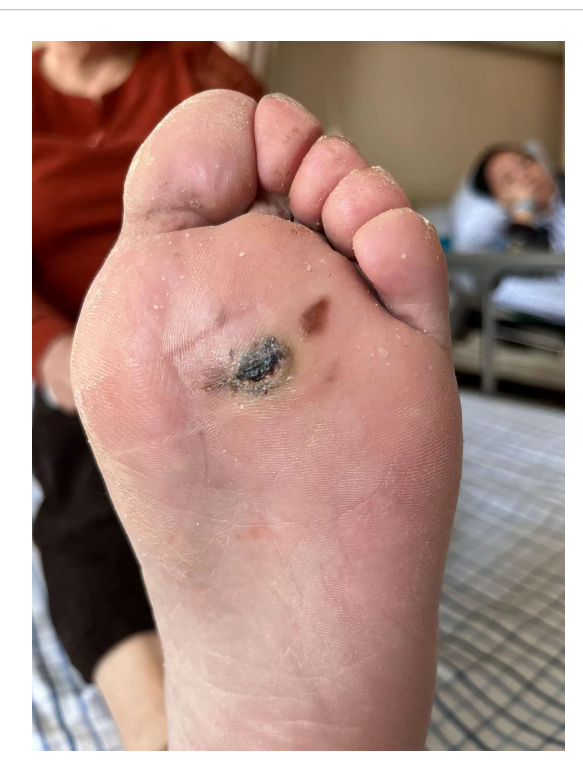
FIGURE 2 Gastroscopy revealed two 0.5 cm × 0.6 cm spots that can be seen arising from the stomach mucosa which were slightly swollen and slightly black in the